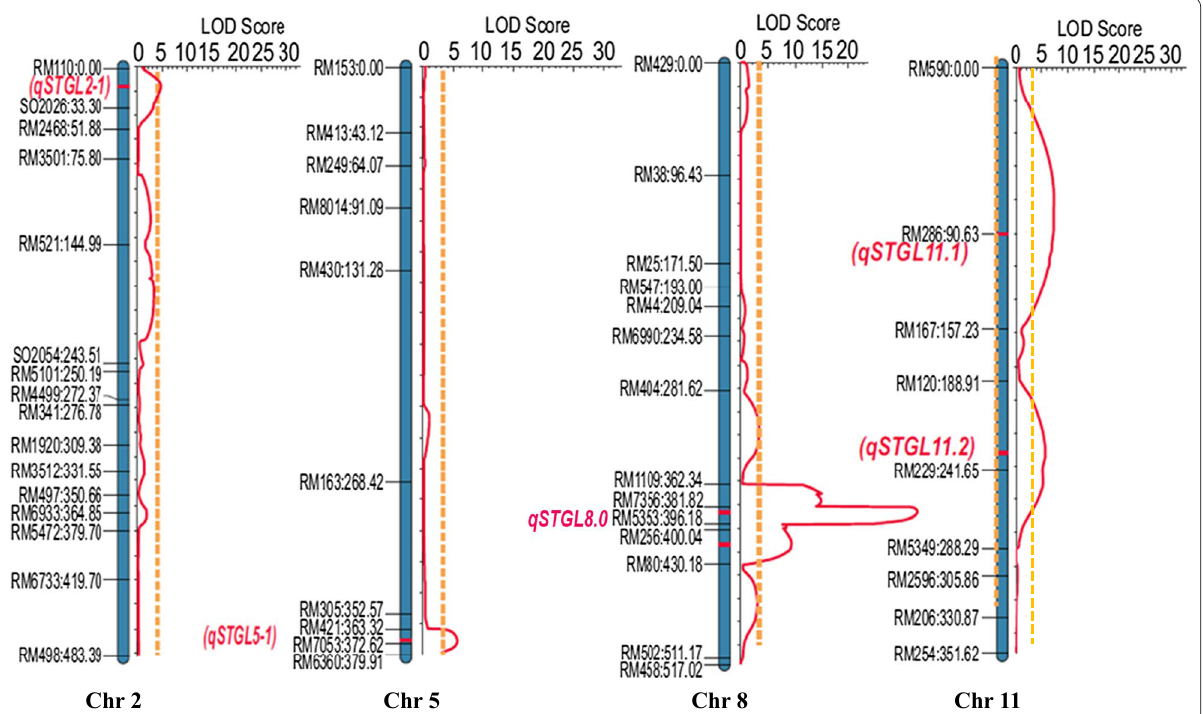
Fig. 2 Diagram showing the QTLs detected for stigma length ( qSTGL2-1, qSTGL5-1, qSTGL8.0, qSTGL11-1, and qSTGL11-2 ) by composite interval mapping using 357 BC 2 F 2 segregants derived from IR64 ×